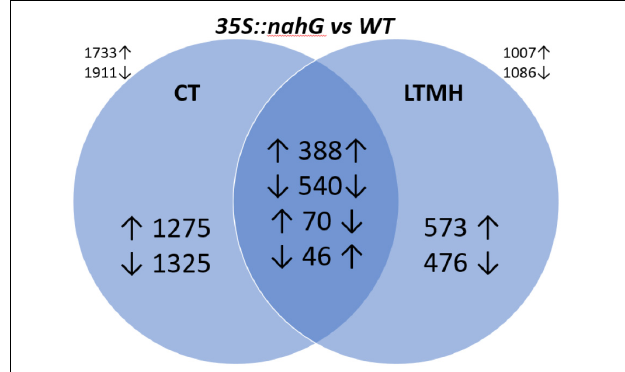
FIGURE 2 | Differentially expressed genes (DEGs) between polarized stage anthers of WT and 35S:nahG in CT and LTMH. LTMH consisted of repeated exposure to 34 ◦ C (day) and 28 ◦ C (night). Values indicate the number of DEGs, and up and down arrows indicate higher or lower expression, respectively, in 35S:nahG . An arrow left to the value indicates the direction of response in CT; on the right, in LTMH. The values outside the diagram indicate the total number of upregulated and downregulated DEGs for the concerning temperature